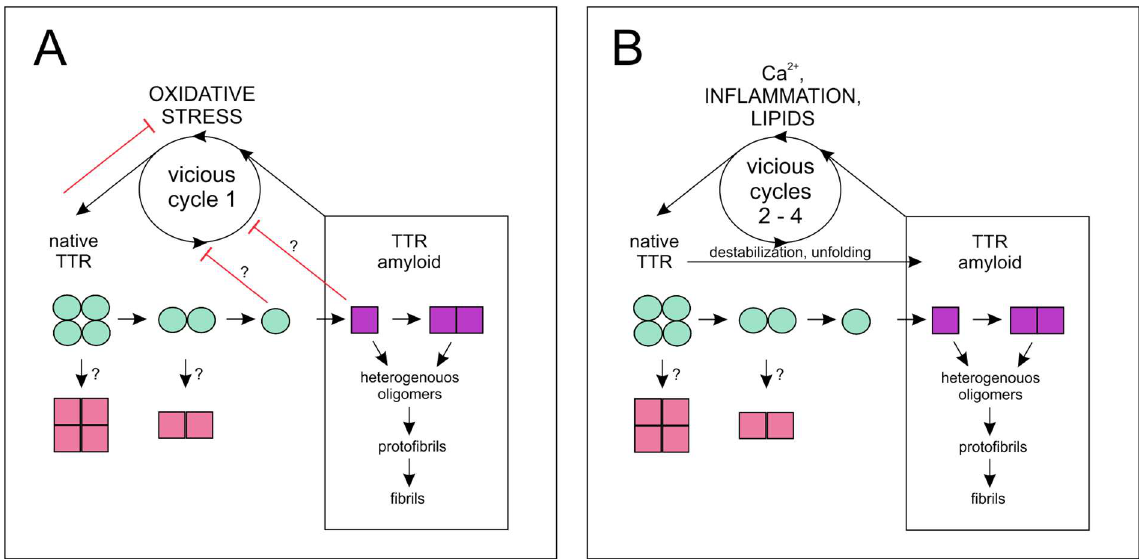
Figure 1. Amyloid formation pathways and vicious cycles of TTR. Models showing amyloid formation pathways and correlations between TTR form/stability and factors that affect TTR stability and drive the vicious cycles. Properly folded and partially unfolded forms of TTR are indicated by circles and squares, respectively. Native TTR tetramers dissociate to unstable dimers and then to monomers. The unfolded, aggregation-prone monomers dimerize, and then form heterogeneous populations of oligomers, some of which assemble into protofibrils and fibrils. Vicious cycle 1 ( A ) differs from other cycles ( B ) in the protective role of TTR against oxidative stress. Question marks denote the direct unfolding (from properly folded) of TTR tetramers and dimers, as well as the contribution of folded and unfolded monomeric forms of TTR in protection against oxidative stress, which requires further research.